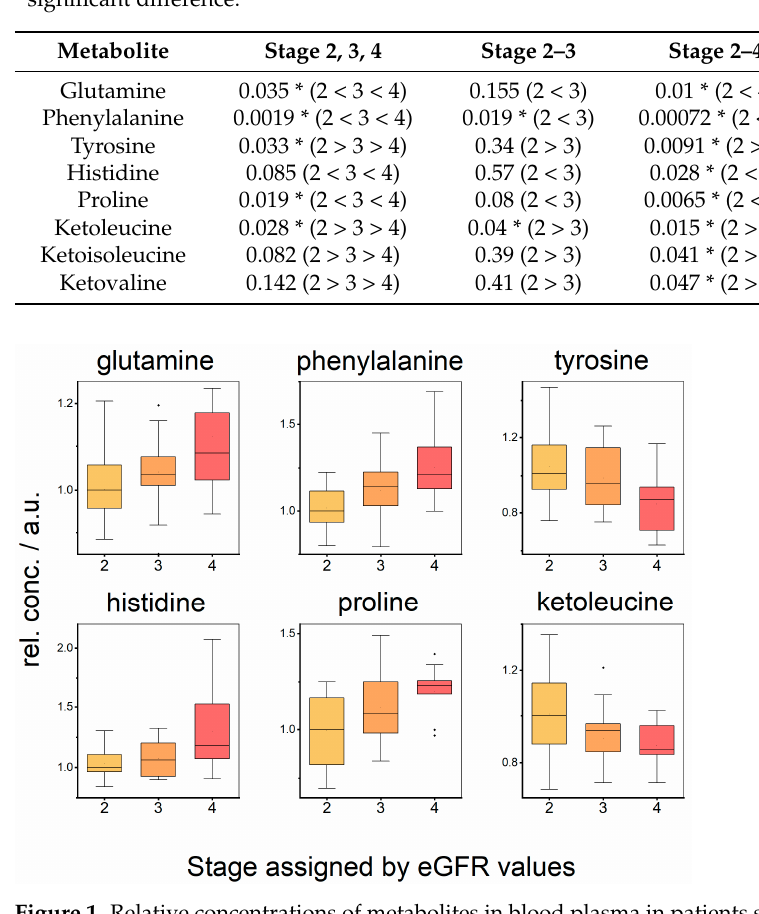
Figure 1. Relative concentrations of metabolites in blood plasma in patients showing kidney function in Stages 2, 3, and 4.